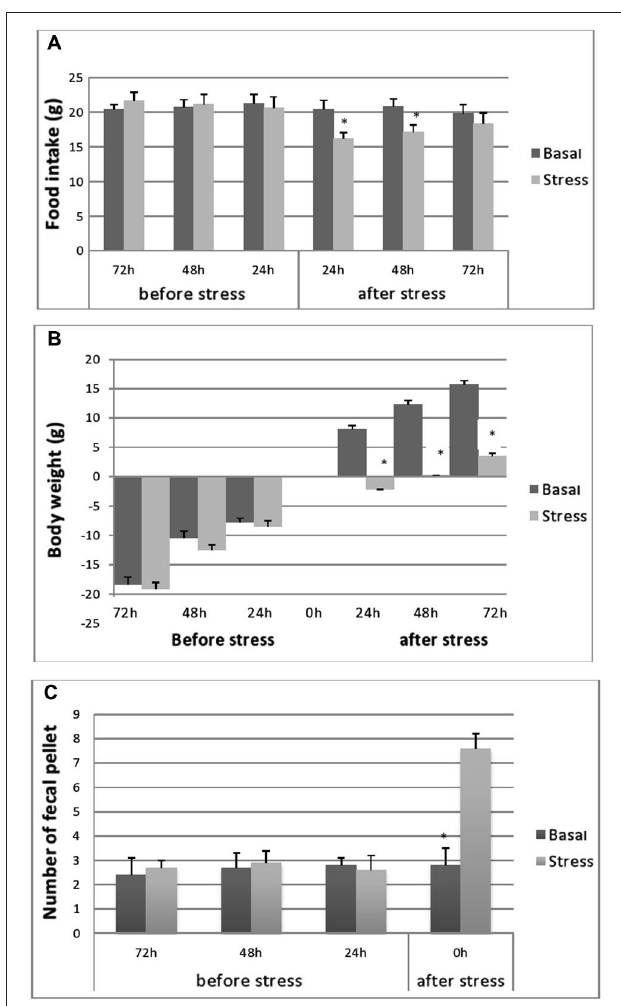
FIGURE 2 | Cumulative food consumption (g) before and after stress (A), body-weight evolution (B) of stressed and control rats during the pre- and post-stress period and fecal pellet production. (C) Fecal pellet production before and during stress. Food consumption and BW evolutions were monitored 72, 48 and 24 h before stress and 24, 48 and 72 h after stress. FI in controls was processed at same points as stressed rats. Data are represented as the mean ± S.E.M. Differences between controls and stressed rats are significant at each experimental point after immobilization session ( p < 0.001) ( n = 5 per group) for FI and BW evolutions and p < 0.001 for fecal pellets